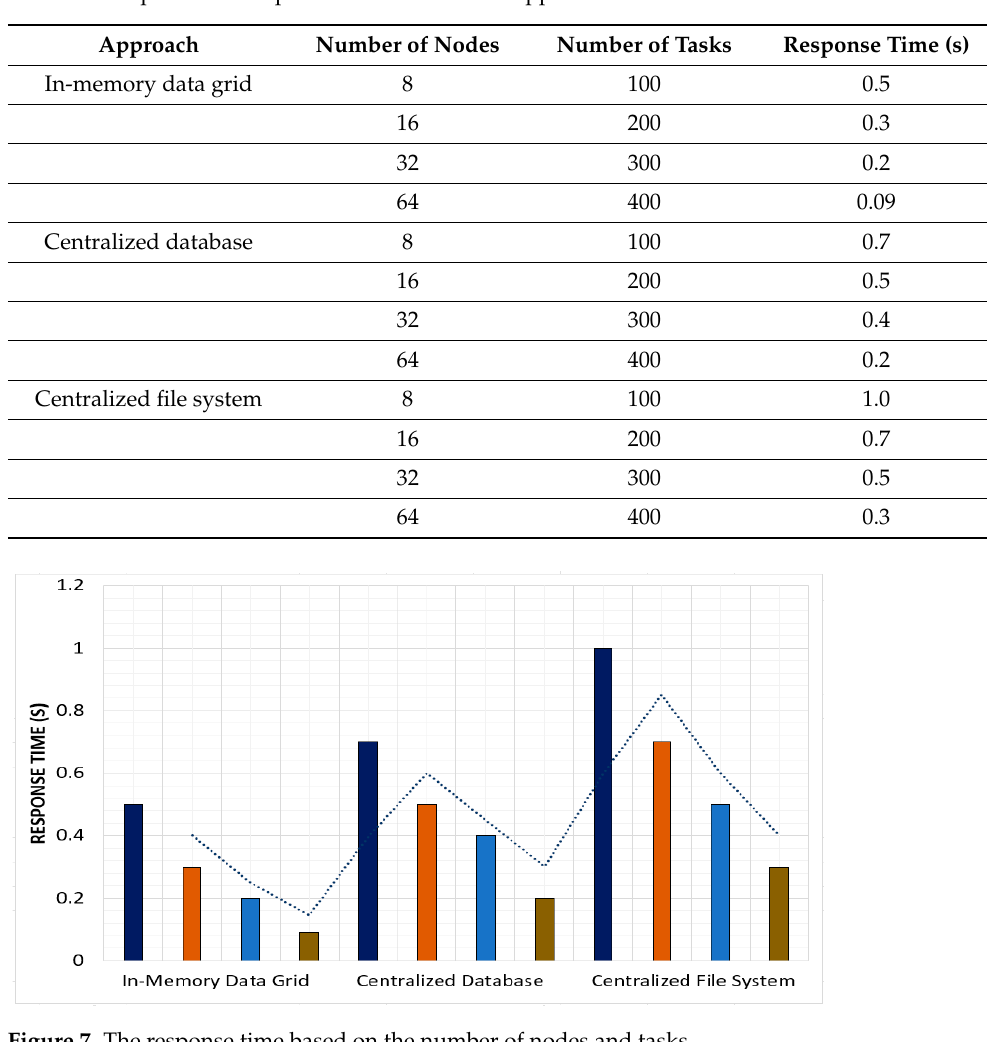
Table 8. Success rate results. Approach